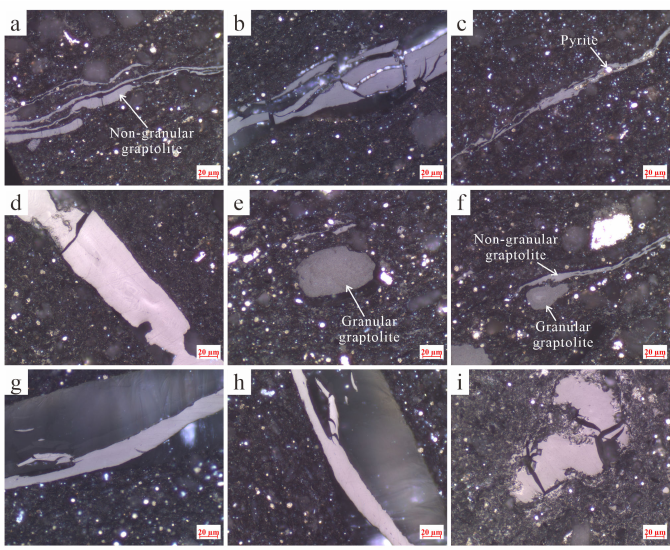
Figure 2. Microphotographs of graptolites in the Wufeng–Longmaxi Formations from southern Sichuan Basin. ( a ) Non-granular graptolite, distributing along the bedding in strips (L207, 3454.72 m, GR or = 3.327%); ( b ) Non-granular graptolite with intermittent form, distributing along the bedding (L207, GR or = 3.172%); ( c ) The common canal contains framboidal pyrite, non-granular graptolite (W202, 2568.20 m, GR or = 3.033%); ( d ) Fusellar layer of non-granular graptolite on parallel bedding section (L204, 3843.70 m, GR or = 5.310%); ( e ) Granular graptolite (L207, 3454.72 m, GR or = 1.794%); ( f ) Granular graptolite and non-granular graptolite (L207, 3454.72 m); ( g ) Non-granular graptolite (L204, 3825.79 m, GR or = 3.873%); ( h ) The same non-granular graptolite as ( g ), with 90 ◦ rotation of the microscope stage to show anisotropy ( GR or = 3.356%). ( i ) Non-granular graptolite may be infected by bitumen (N222, 4327.14 m, GR or =